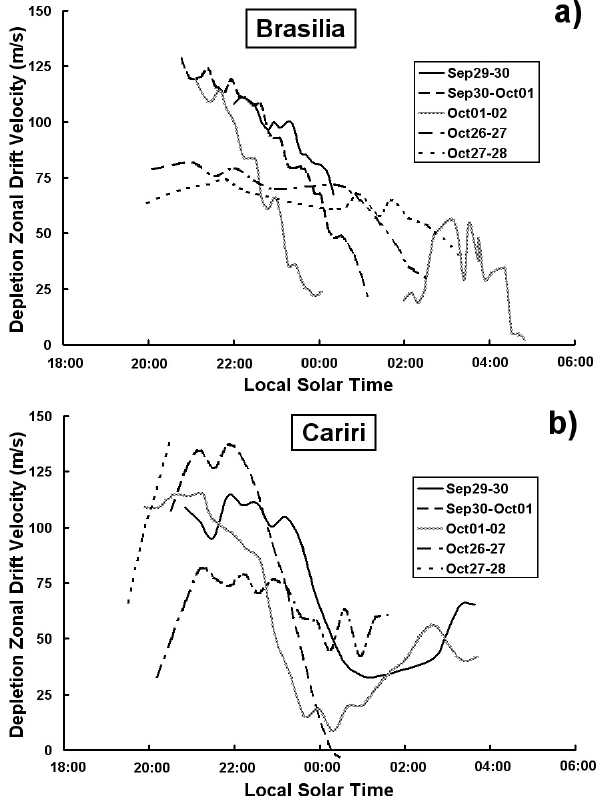
Fig. 4. Spread-F phase velocity as a function of Solar Local Time as observed from Brasilia (a) and Cariri (b) , during 5 nights of ex- tensive